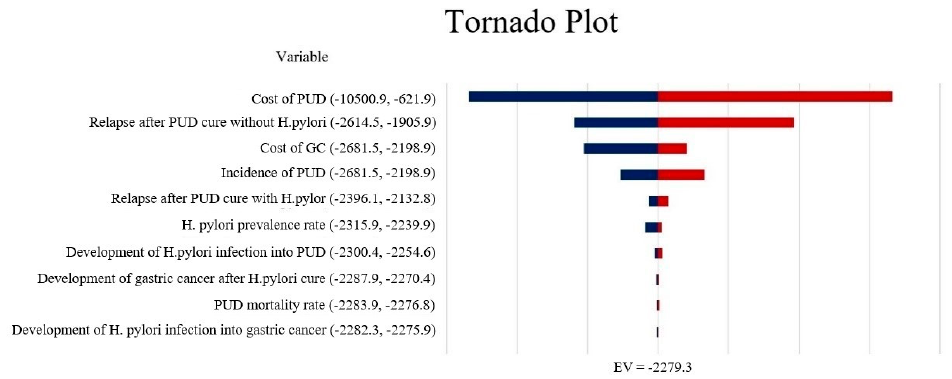
Figure 2. Tornado diagram showing the deterministic sensitivity analysis of the Markov model simulation.